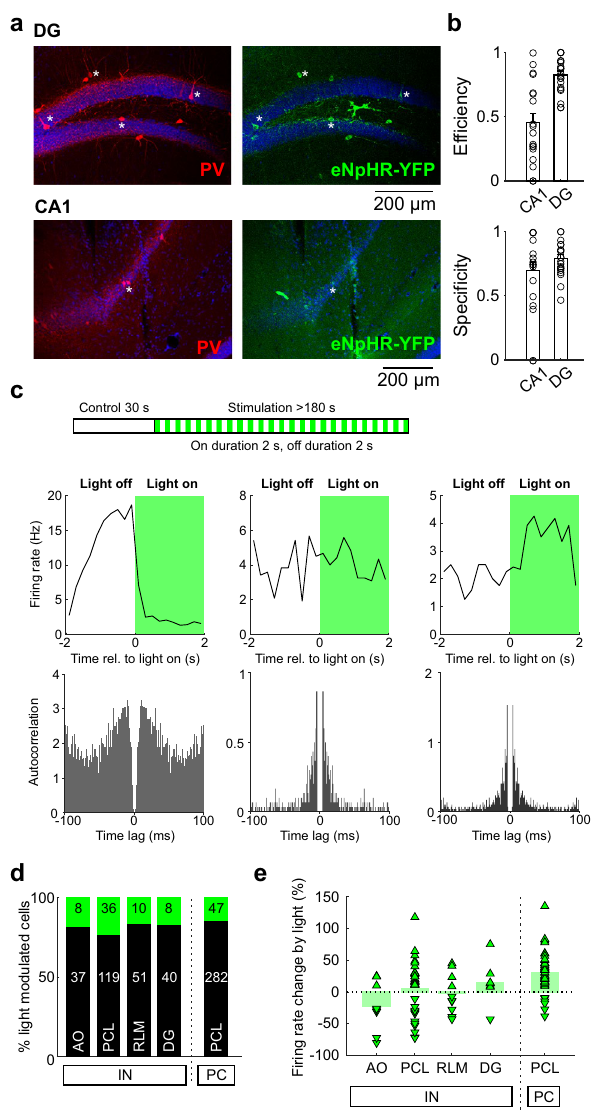
Figure 1. eNpHR-mediated silencing of hippocampal PV + interneurons (PVIs). ( a ) Representative fluorescence microscopical pictures showing PV expression (red, left) and YFP infection (green, right) in DG (top) and CA1 (bottom). Note the vertical electrode tracks. White asterisks indicate neuronal somata. ( b) Quantification of efficiency (top) and specificity (bottom) of PVI infection for four animals. Open circles represent individual brain slices, bars and error bars indicate mean and SEM. ( c) Top, schematic illustrating the light stimulation protocol. After a 30 s control period with the light being switched off, 561 nm light is switched on and off alternately for ≥ 180 s with individual light on and light off periods of 2 s. Middle, average firing rate histograms aligned to the onset of light stimulation (at 0 ms time lag). Depicted are three different single units responding with a clear reduction in the activity (left), no firing rate change (middle) and an increasing activity level (right) during light stimulation (green area). Bottom, autocorrelograms of the corresponding single units shown on top. ( d ) Percentage of putative INs (left) and CA1 PCs (right) with either no change (black bars) or a significant change in firing rate in response to light stimulation (green section on top of the black bars). White numbers indicate the absolute numbers of neurons in the different anatomical regions (AO, alveus/oriens; PCL, pyramidal cell layer; RLM, radiatum/lacunosum-moleculare; DG, dentate gyrus). ( e ) Relative change in the firing upon light stimulation shown only for the significantly light-modulated single